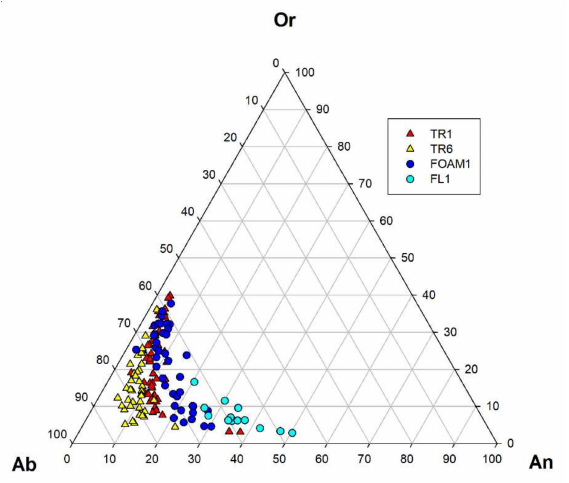
Figure 6. Ternary classification diagram showing the composition of feldspar in trachyandesites and highly vesiculated